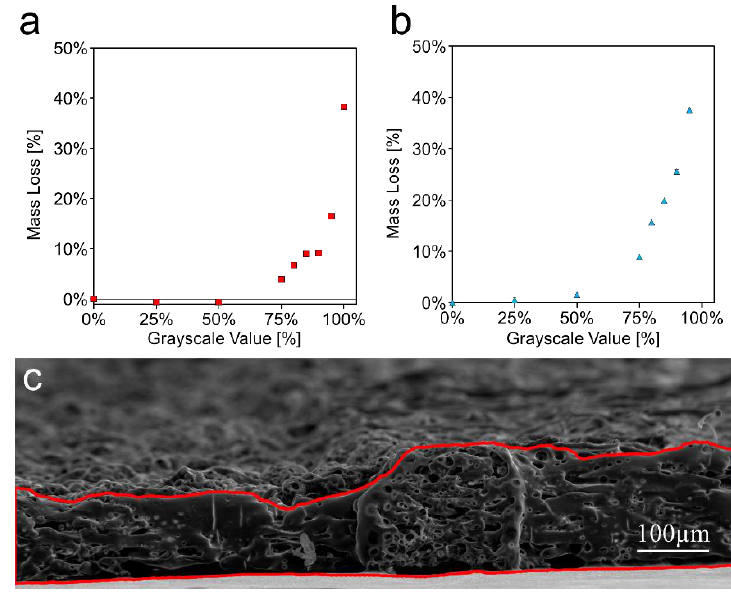
Figure 3. Mass loss caused by laser etching. ( a ) Percent mass loss at each etching level of single-sided etched paper. 50 × 50 mm squares of Whatman #1 chromatography paper were weighed after being etched at each grayscale value. n = 10. ( b ) Percent mass loss at each etching level of double-sided etched paper. Paper disintegrated when etched at 100% on both sides. Data presented as mean ± SD. n = 10. ( c ) SEM image showing the effect of etching on the cross-sectional area of the paper. The region on the left has been etched at 100% on a single side while the region on the right has not been etched.